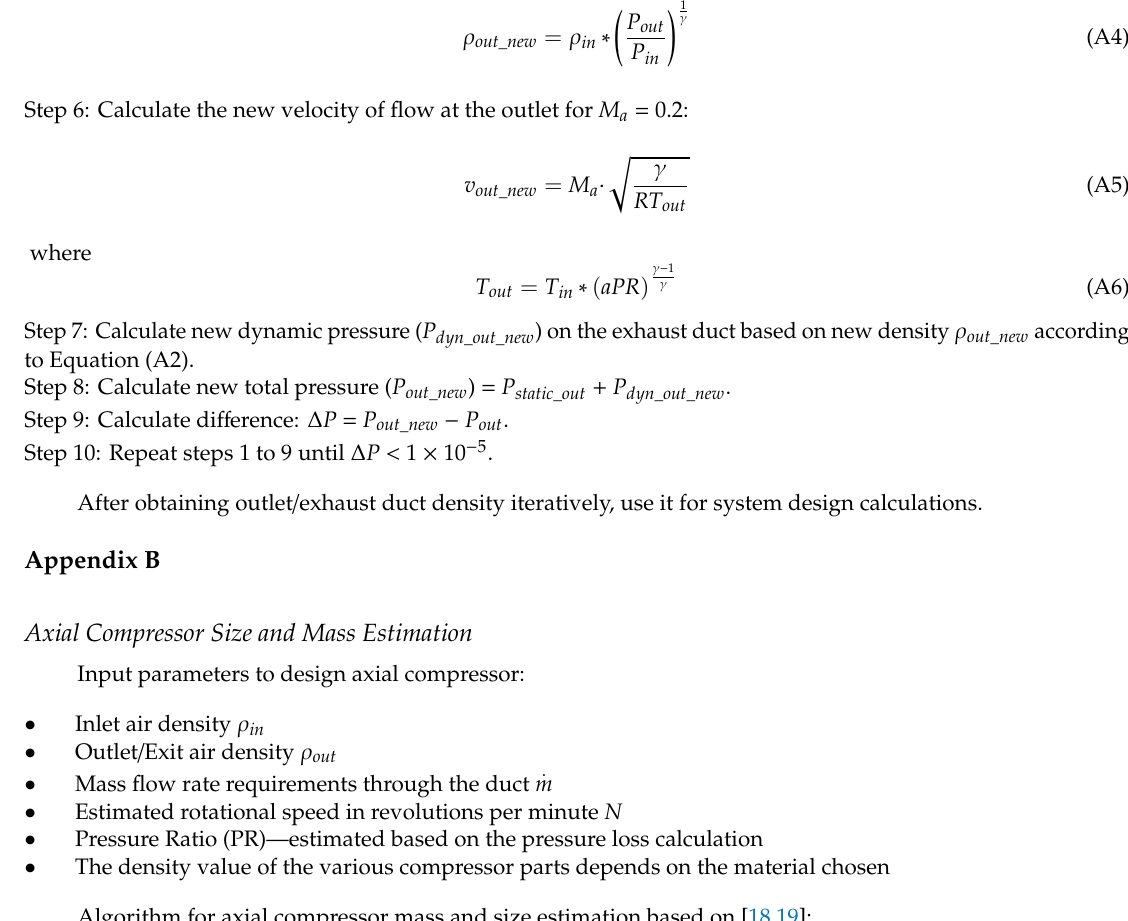
The density value of the various compressor parts depends on the material chosen Algorithm for axial compressor mass and size estimation based on